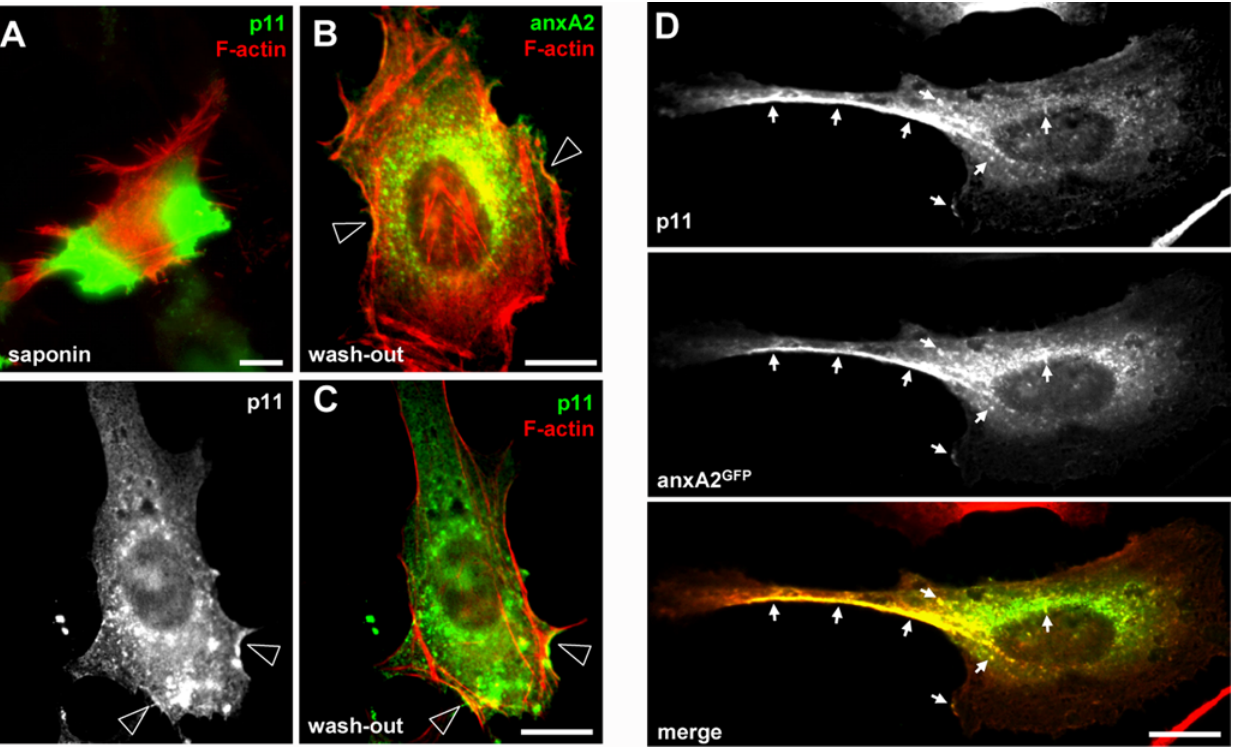
Figure 1. subcellular localization of p11 compared to F-actin and annexin A2. The distribution in HeLa cells of p11 (H21 monoclonal antibody), AnxA2 (HH7 monoclonal antibody, and F-actin (phalloidin) was analyzed by immunofluorescence using a conventional saponin-based permeabilization protocol (A) or a protocol optimal for AnxA2 and p11 detection after cytosol wash-out (B–D), as follows: (A) p11 and F-actin double fluorescence after saponin-based permeabilization; (B) AnxA2 and F-actin double fluorescence after cytosol wash-out; (C) p11 and F-actin double fluorescence analysis after cytosol wash-out; (D) p11 and AnxA2-GFP double fluorescence analysis after cytosol wash-out. Arrowheads in B and C indicate concentrated AnxA2 and/or p11 bundles at cell surface, with strong colocalization with F-actin. Arrows in D indicate p11/AnxA2 colocalization. Bar: 10 m m.